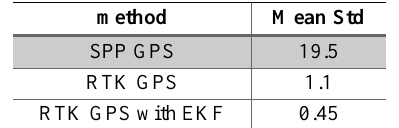
Table 4: Mean Std achieved for all extracted